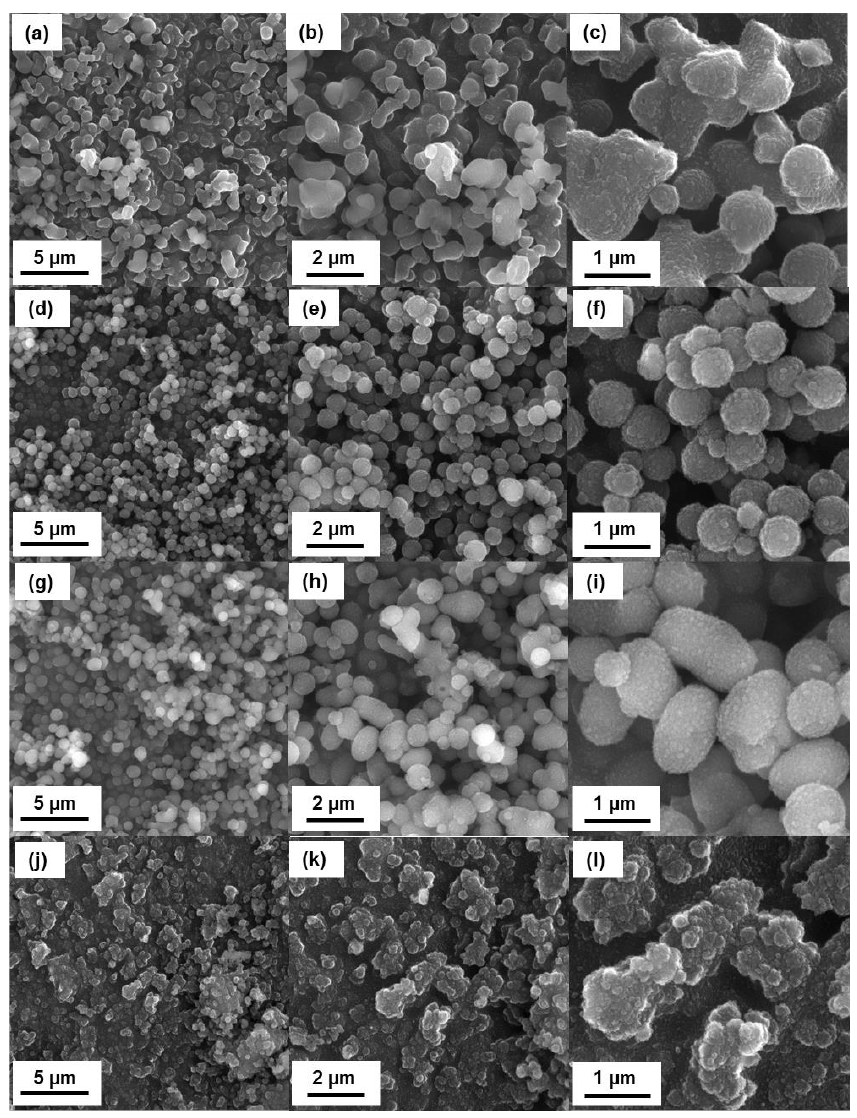
Figure 1. SEM images of ( a – c ) G0, ( d – f ) G1, ( g – i ) G2, and ( j – l ) G3, shown at three different magnifications. Table 1. Particle size distribution and polydispersity index of the prepared